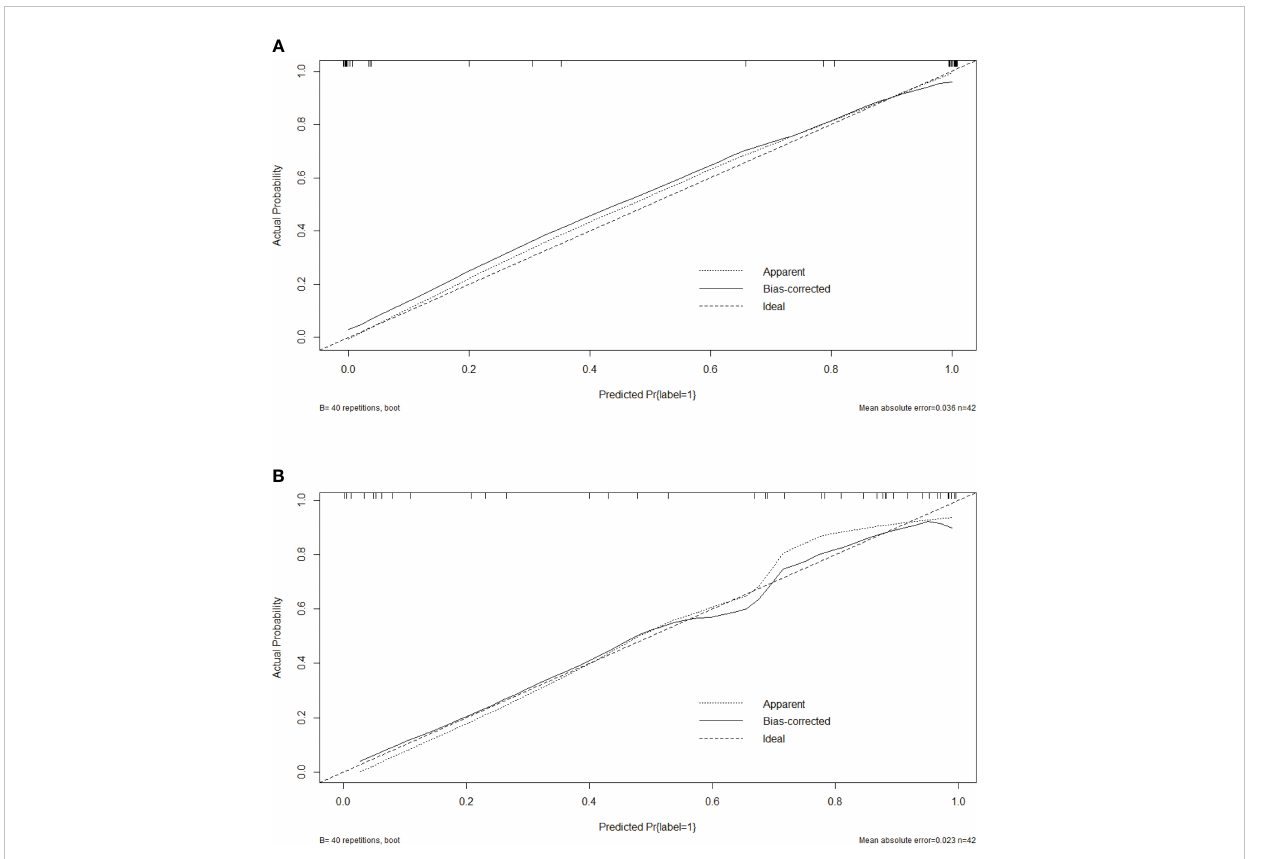
FIGURE 6 Calibration curves of the radiomics nomogram in training cohort (A) and test cohort (B)